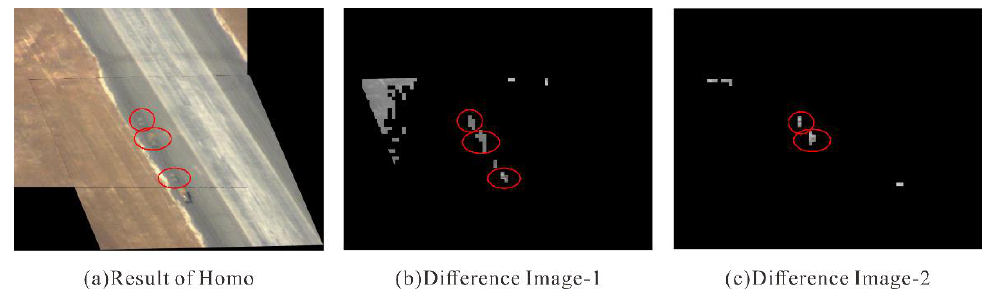
Figure 8. Comparison of larger threshold and appropriate threshold.